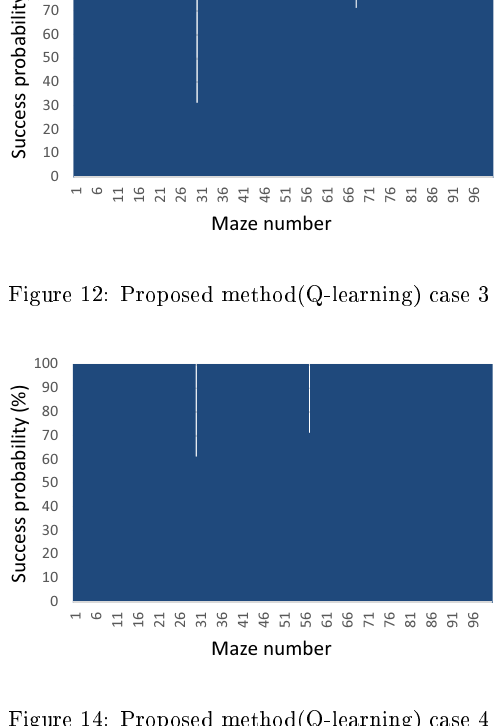
Figure 14: Proposed method(Q-learning) case 4 Figure 15: Proposed method(Pro(cid:28)t Sharing) case 4 Figure 16: Q-learning vs Pro(cid:28)t